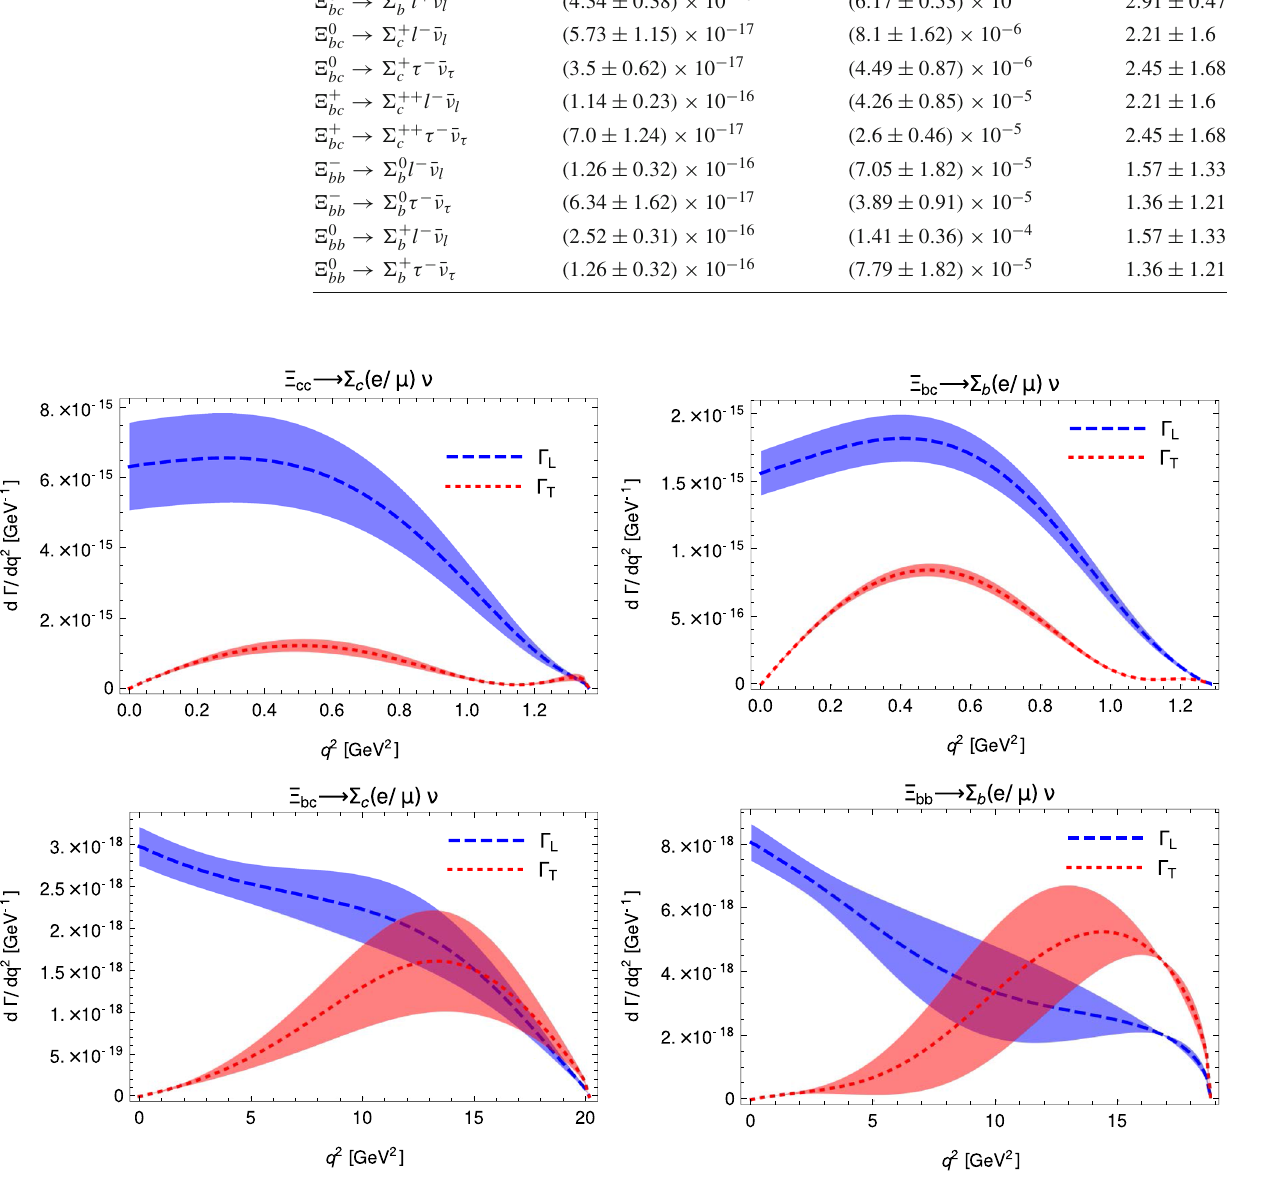
Fig. 3 q 2 dependence of the semi-leptonic (cid:2) QQ (cid:2) q decaywidths. d (cid:24) L / dq 2 areshownbythebluebandswhile d (cid:24) T / dq 2 are shown by the red bands. The dashed lines are the center value curves